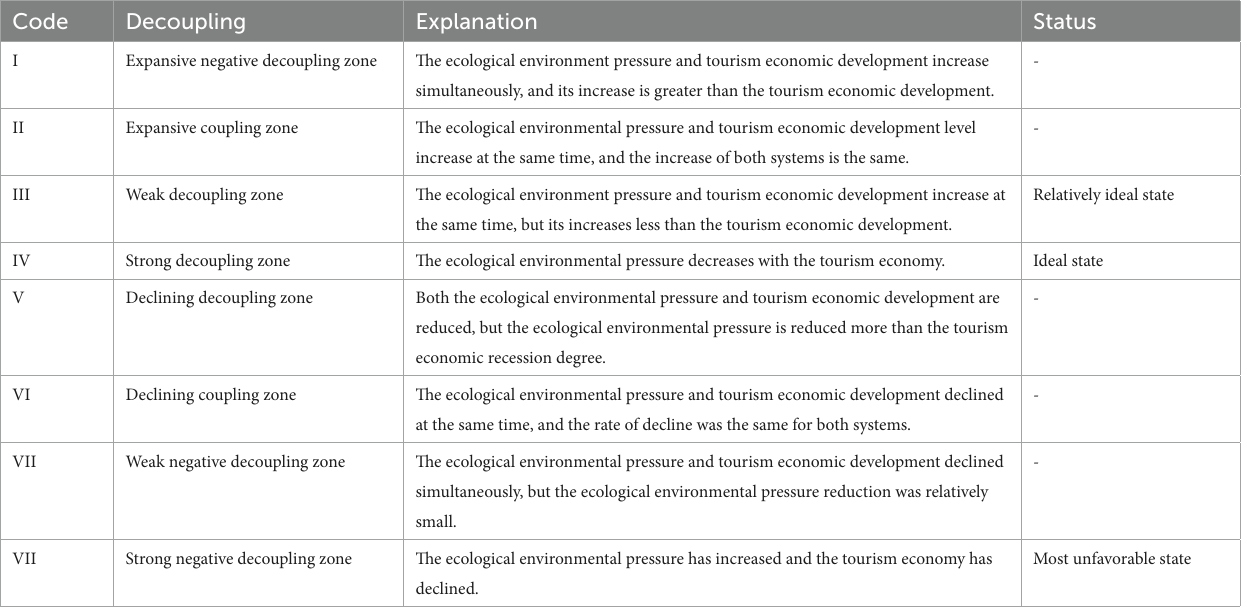
TABLE 2 Eight different types of decoupling